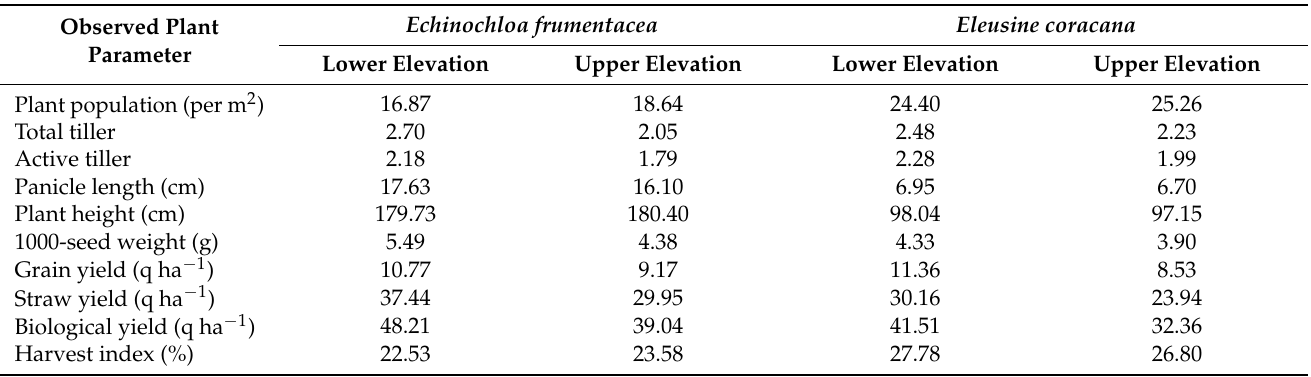
Table 5. Average growth and yield attributes of E. frumentacea and E. coracana at two elevations under G. oppositifolia -based agroforestry